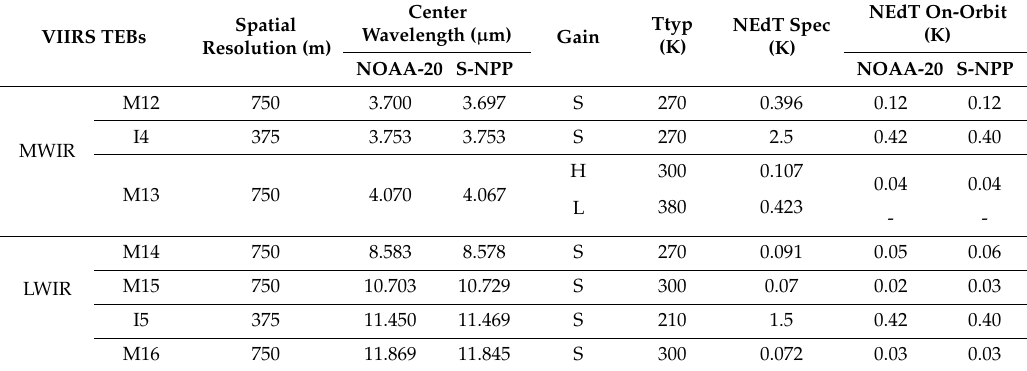
Table 1. Spectral, spatial, and radiometric characteristics of NOAA-20 and S-NPP VIIRS TEBs. I4-I5, M12, M14-M16 are single gain (S) bands. M13 is a dual gain band (H: high gain; L: low gain). Ttyp stands for typical scene temperature; NEdT stands for noise equivalent di ff erential temperature. Center Spatial Wavelength ( µ VIIRS TEBs Resolution (m)